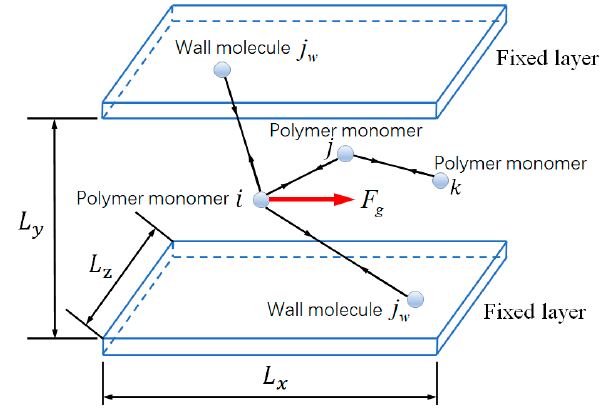
Figure 4. Force analysis of polymer flow.